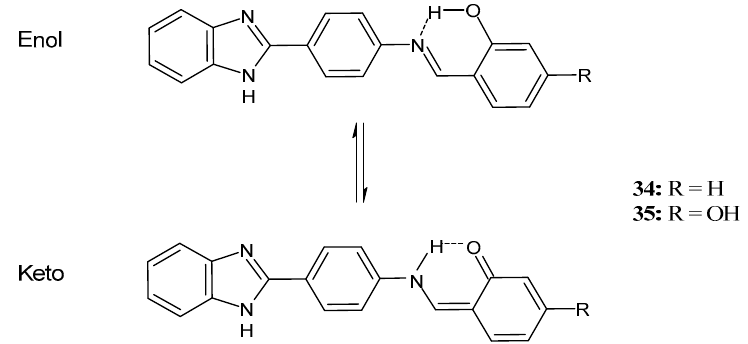
Figure 2. Keto–enol equilibrium of 34 and 35